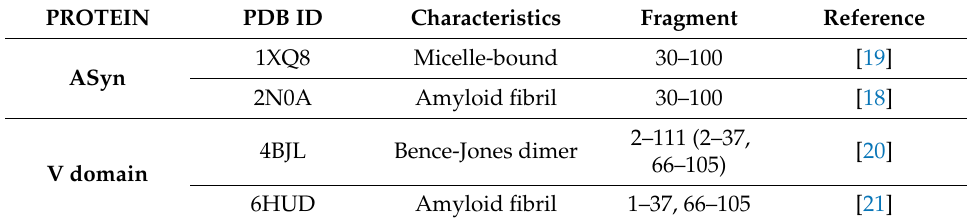
Table 8. A set of proteins being the subject of analysis along with their brief characteristics.